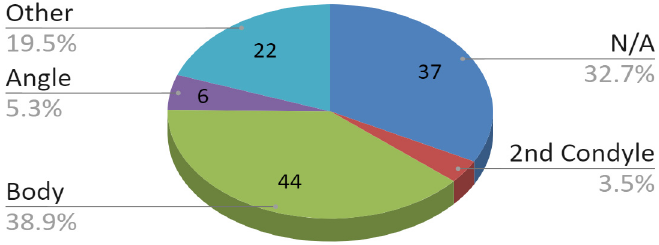
Figure 6. Concomitant fractures of the mandible.